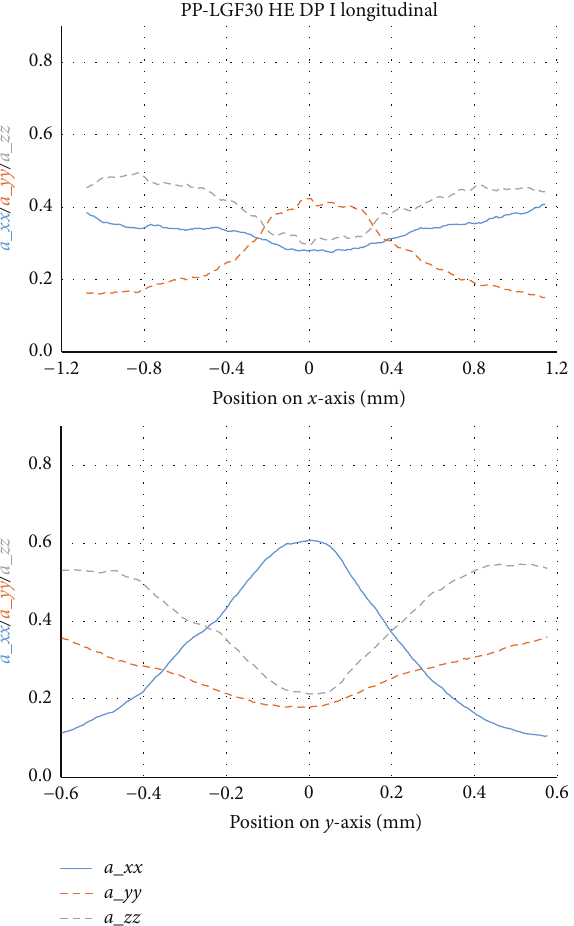
Figure18:Progressofthefiberorientationalongthe 𝑥 -and 𝑦 -axisin the weld of two plates in hot plate welding of PP-LGF30 with initial fiber orientation being longitudinal to the joining direction.